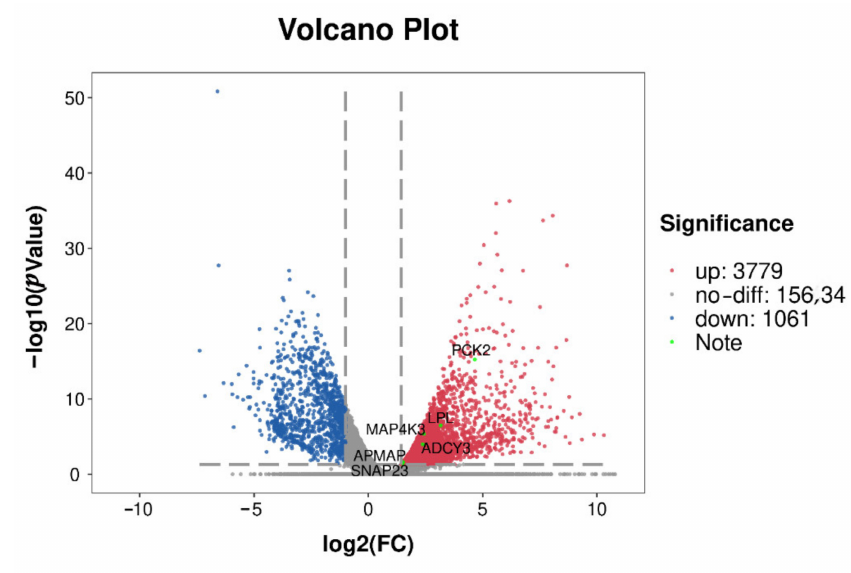
Figure 6. Volcanic map of differentially expressed